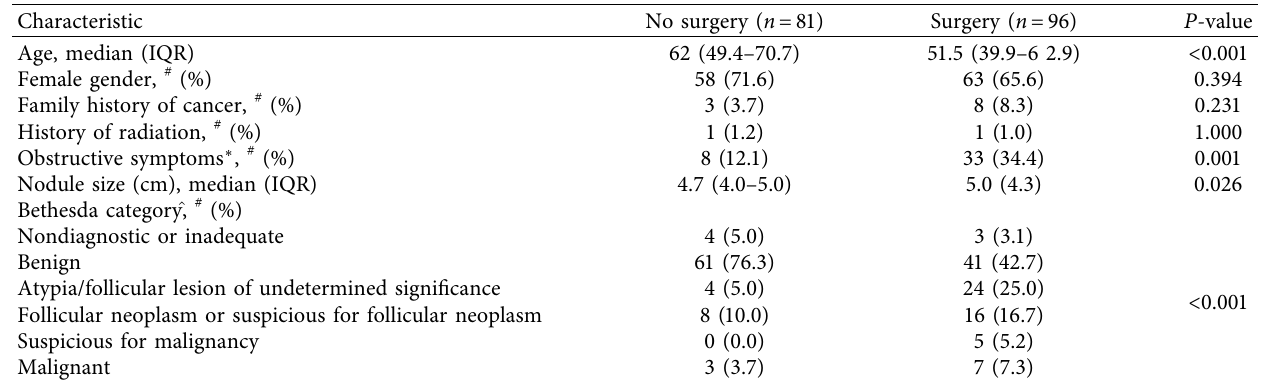
Table 2: Characteristics of patients by surgery status.